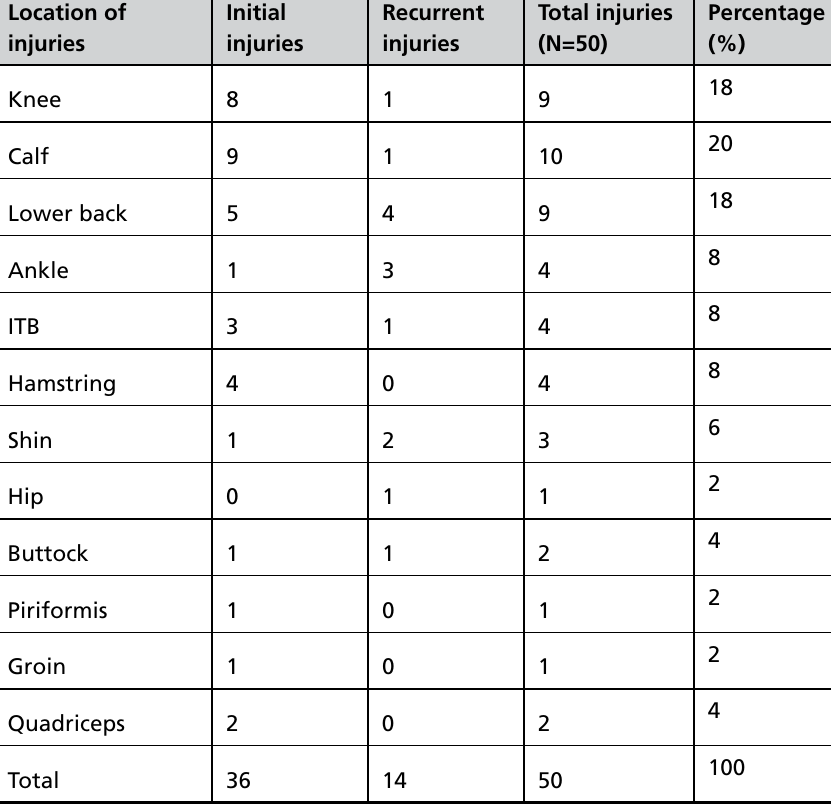
table 3: number of running injuries reported over 16 week period